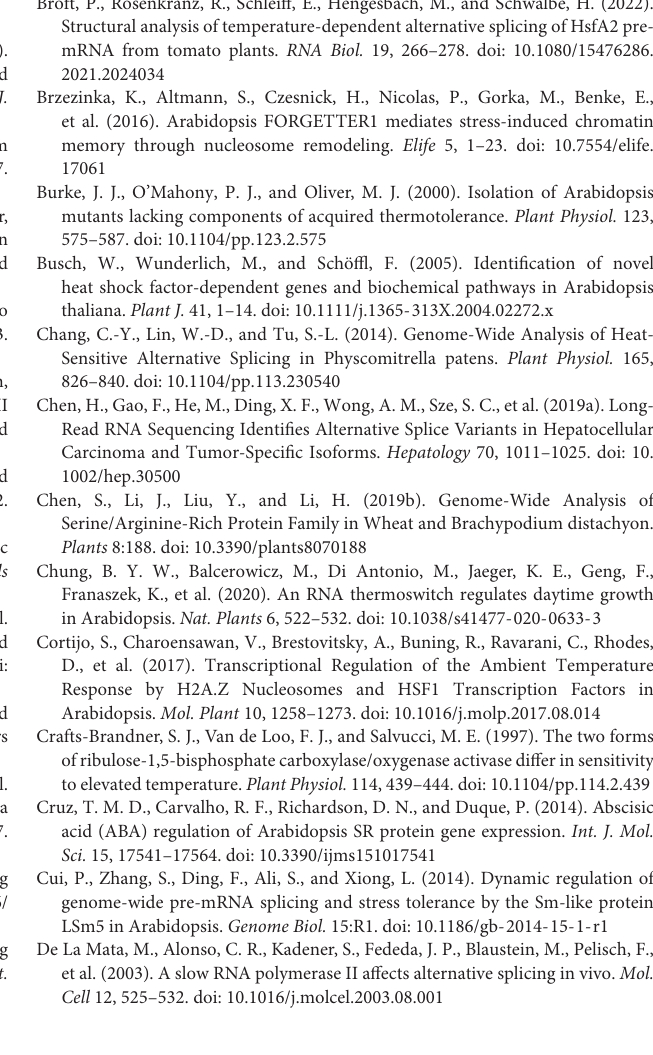
Supplementary Table 1 | List of tomato pre-mRNA splicing genes and their transcript levels under different temperatures. Tomato orthologous genes of splicing related proteins were obtained by ASRG database (Wang and Brendel, 2004) using InParanoid (Sonnhammer and Östlund, 2015; Simm et al., 2016). The transcript levels were obtained from Hu et al. (2020a) on seedlings of four different cultivars kept under 25, 39 or 45 ◦ C for 1 h. Transcript levels are based on Massive Analysis of cDNA Ends (MACE) and presented as transcripts per million